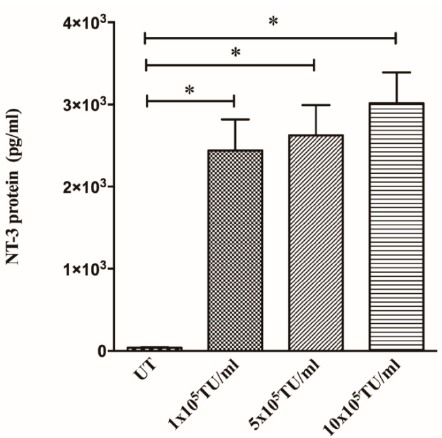
Figure 1. 293T cells produce significantly more NT-3 protein following transduction with NT-3 lentiviral vector. Graph shows the concentration of NT-3 protein, determined by ELISA, in media from untransduced (UT), 1 × 10 5 TU / mL, 5 × 10 5 TU / mL and 10 × 10 5 TU / mL. Lenti-NT-3-transduced 293T cells after 3 days in culture. Mean ± SEM. * p ≤ 0.05, ** p ≤ 0.01, *** p ≤ 0.001. n = 3. Tukey’s post-hoc test using one-way ANOVA.